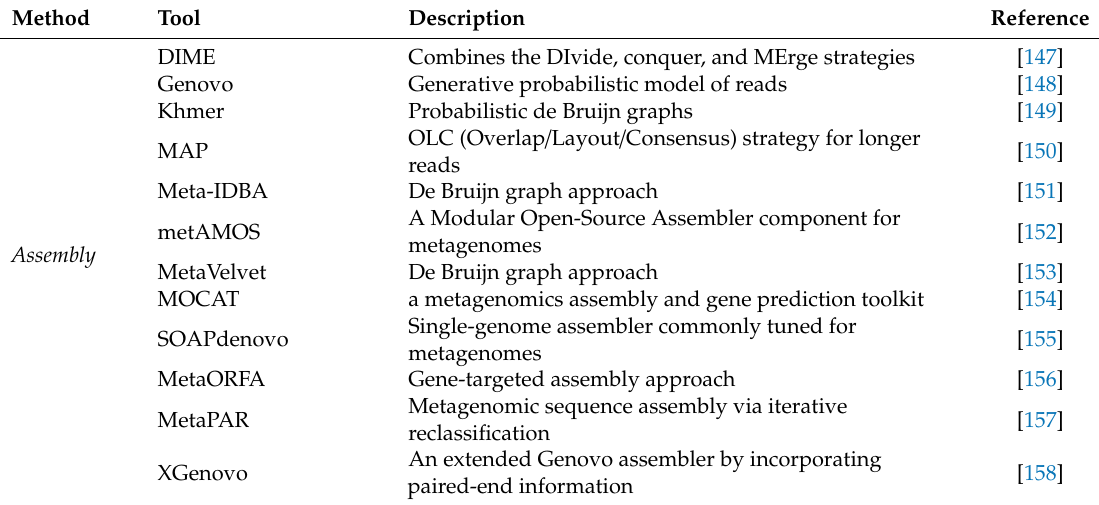
Table 2. Computational methods for meta-omic analysis (modified from